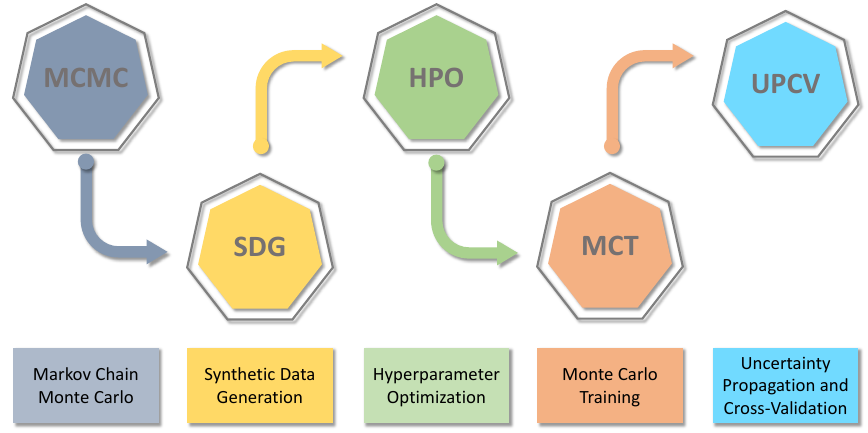
Figure 1. General methodology